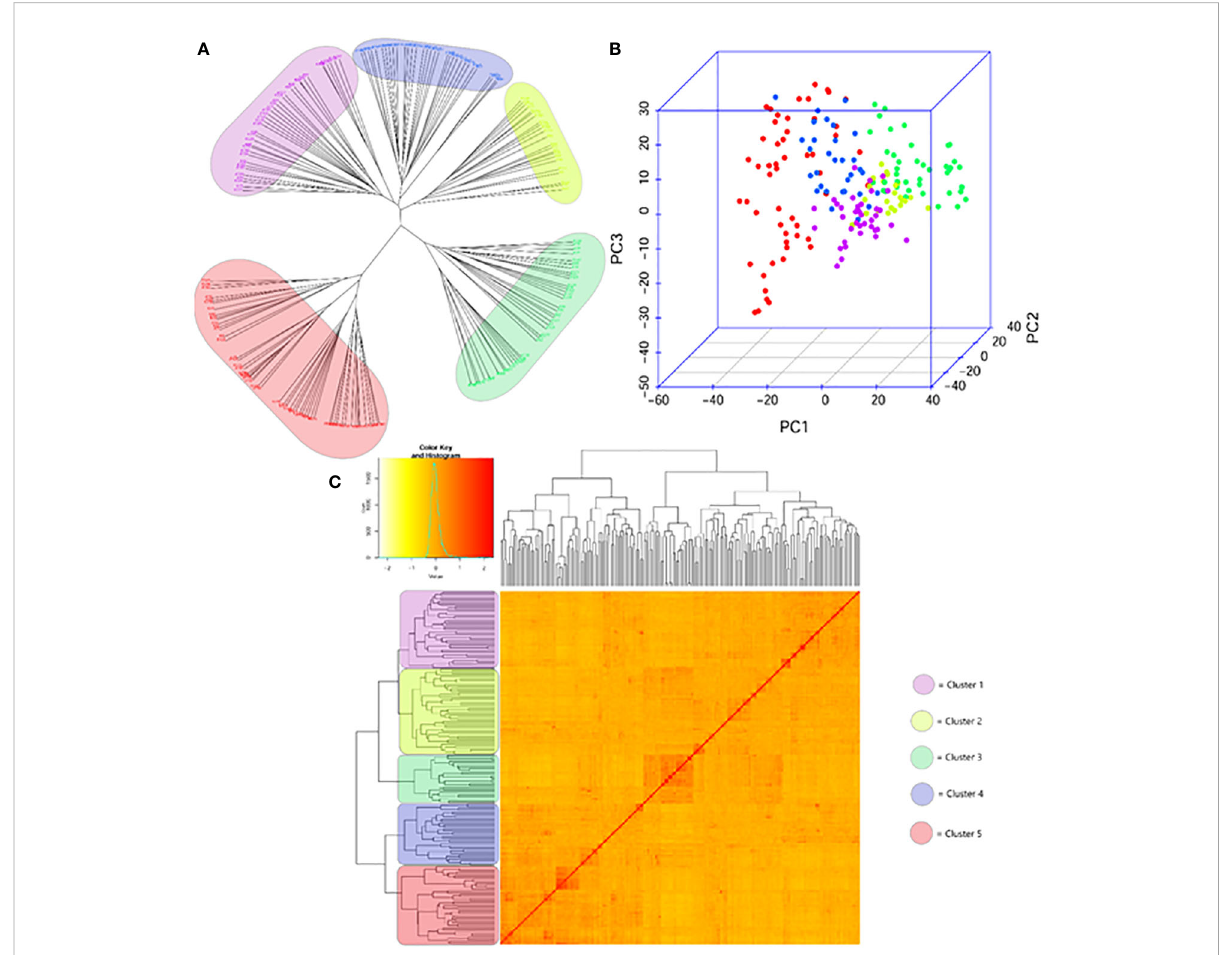
FIGURE 1 Genetic diversity and population structure of the genome wide association panel consisting of 188 winter and facultative wheat cultivars of diverse geographic origins; (A) NJtree, (B) PCA plot and (C) KS matrix. The colour scheme is as follows: Cluster 1 – pink; Cluster 2 – yellow, Cluster 3 – green, Cluster 4 – blue and Cluster 5 –